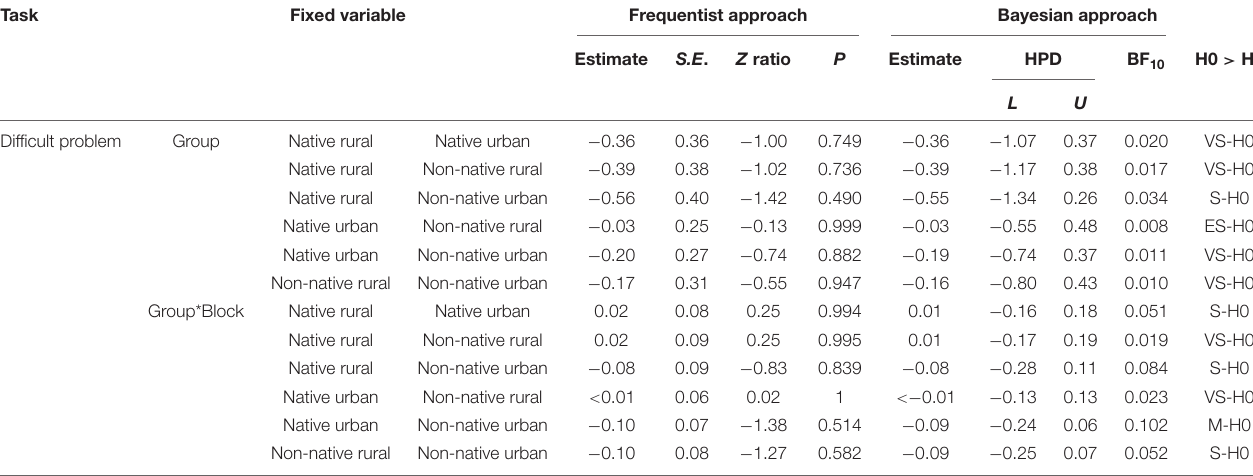
Task Fixed variable Frequentist approach Bayesian